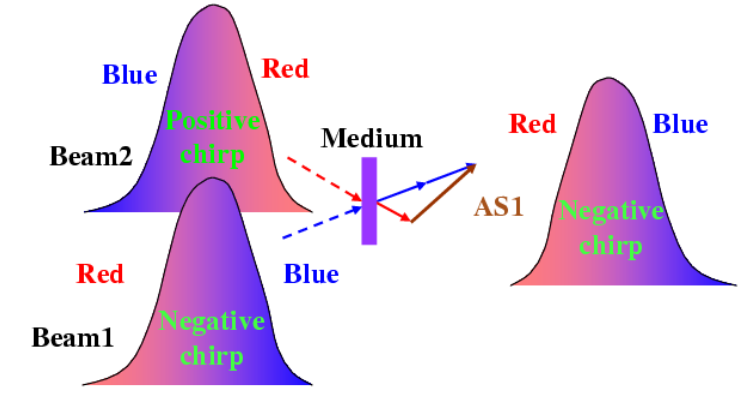
Figure 11. Schematic mechanism of negative CFWM sideband generation with positively and negatively chirped input pulses